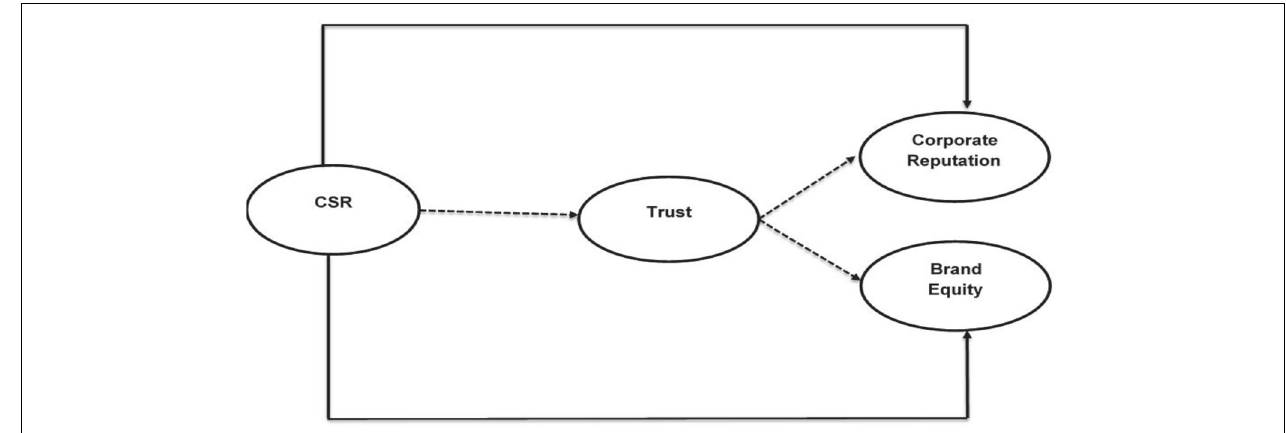
FIGURE 1 | Conceptual model. Solid lines show the direct relationship, and dashed lines show the indirect relationship.